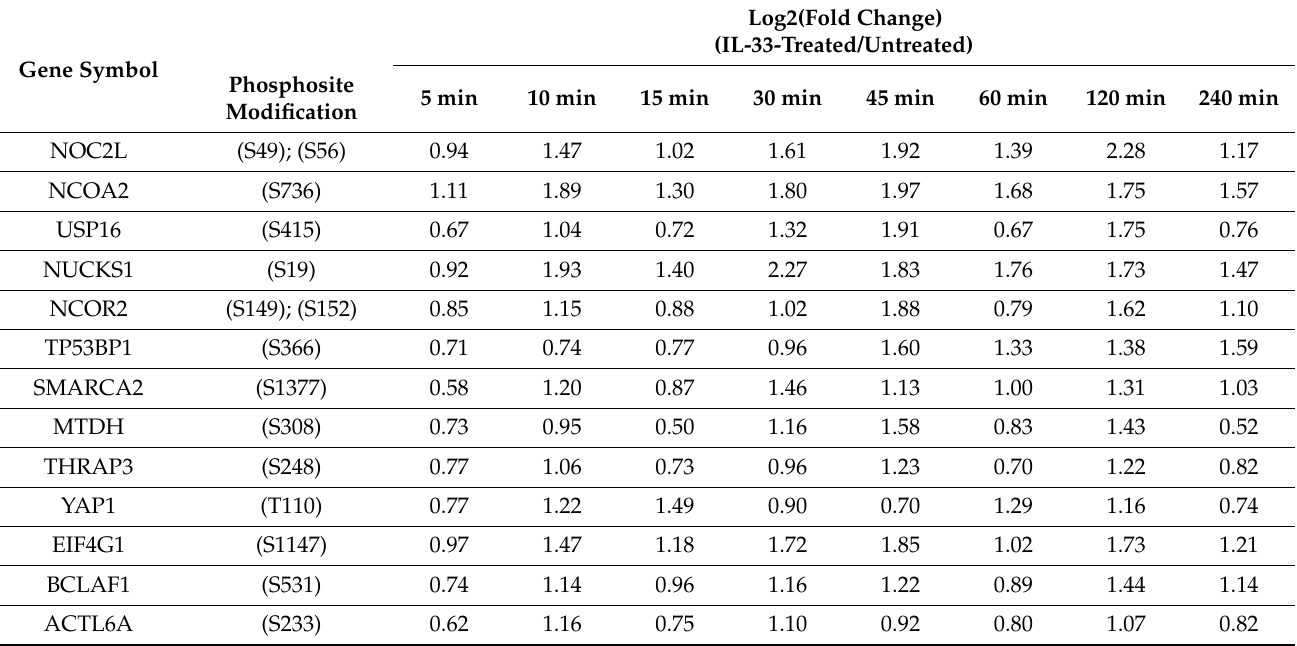
Table 1. Partial list of the differentially regulated phosphoproteins upon IL-33